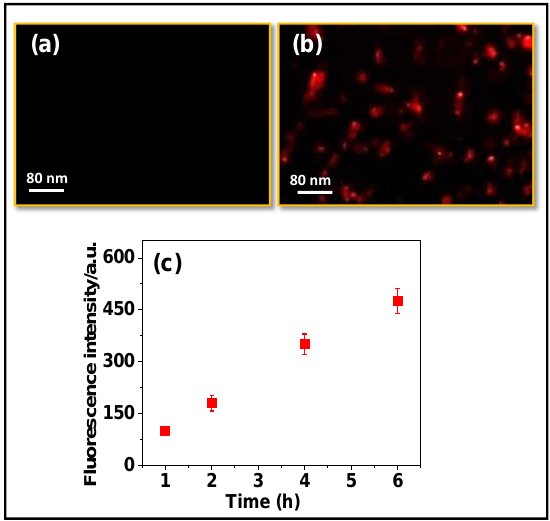
Figure 6. Fluorescence microscopy images of MDA-MB-231 cells; ( a ) only control cells without exposing FeNP@MSHC/Dox NPs; ( b ) the cells exposed with the Dox loaded FeNP@MSHC/Dox NPs. The red signals indicate the released Dox inside the MDA-MB-231 cells. ( c ) Fluorescence intensity of the released Dox from the FeNP@MSHC/Dox NPs at different time intervals. Scale bar = 80 μm.